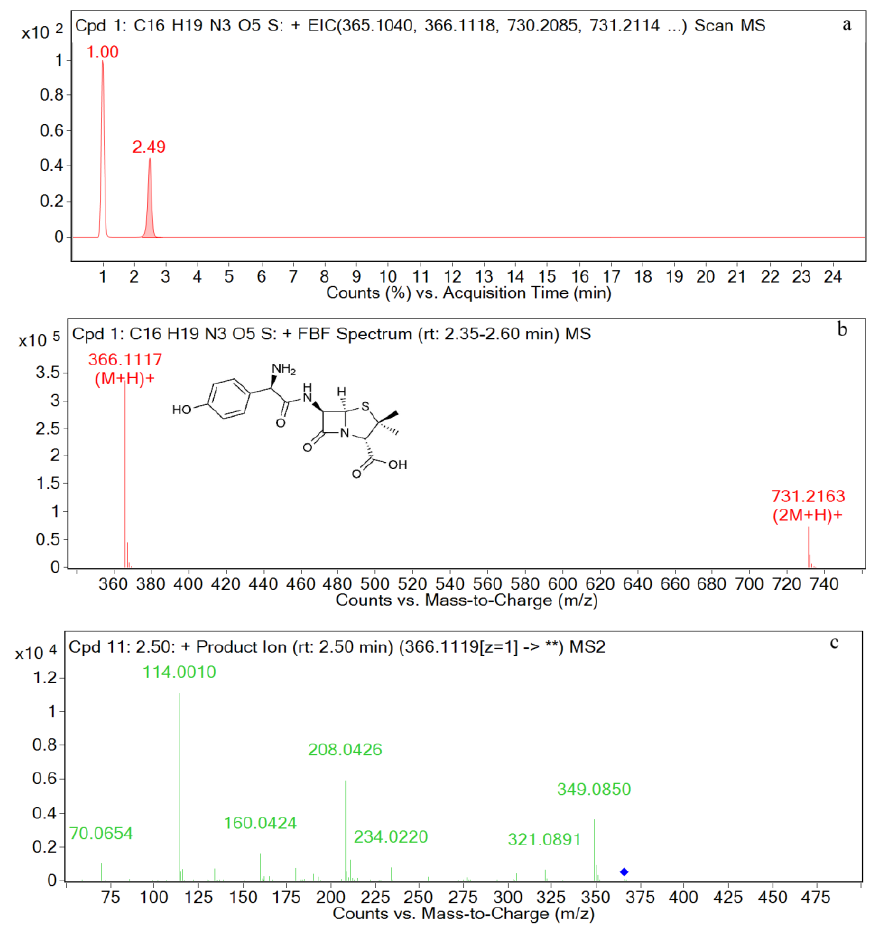
Figure 4. EIC and mass spectrometry results for amoxicillin. ( a ) EIC spectrometry results for amoxicillin; ( b ) Mass spectrum of amoxicillin; ( c ) Two-stage mass spectral data of amoxicillin. The EIC and mass spectrometry results for amoxicilloic acid are shown in Figure 5. The retention time is 2.2 min, and the ion peak is m / z 384.1223 [M+H] + . The fragment ions are m / z 367, m / z 323, m / z 189, m / z 160, m / z 229, m / z 277, and m / z 107. The characteristic ions are m / z 367, m / z 323, and m / z 189.